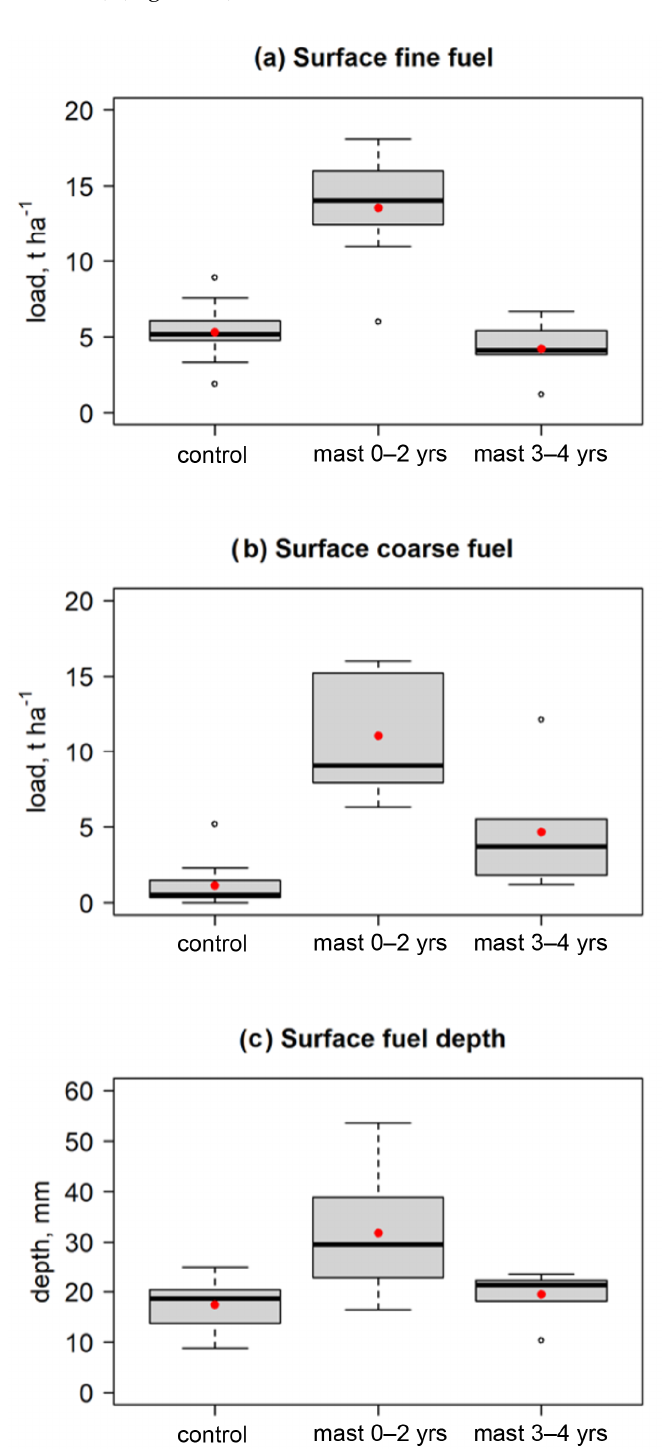
Figure 4. Box plots of dead surface fuel load (t haP − 1 P) for ( a ) dead fine fuels, ( b ) dead coarse fuels and ( c ) surface fuel depth (mm) for 0–2 years post mastication, 3–4 years post mastication and control. The mean value is depicted by the red dot.